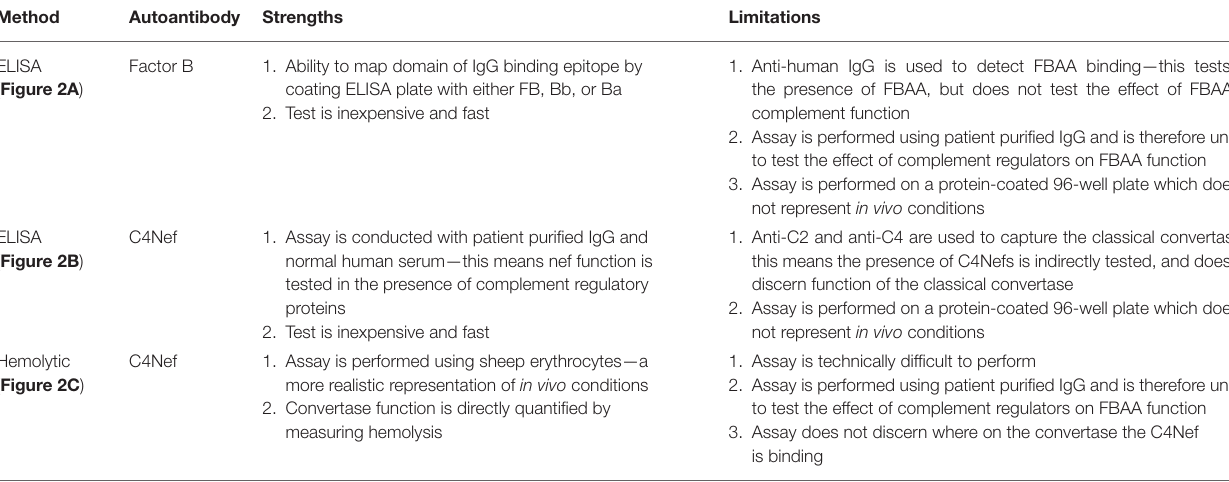
TABLE 1 | Methods for detection of Factor B autoantibodies and C4 nephritic factors. Method